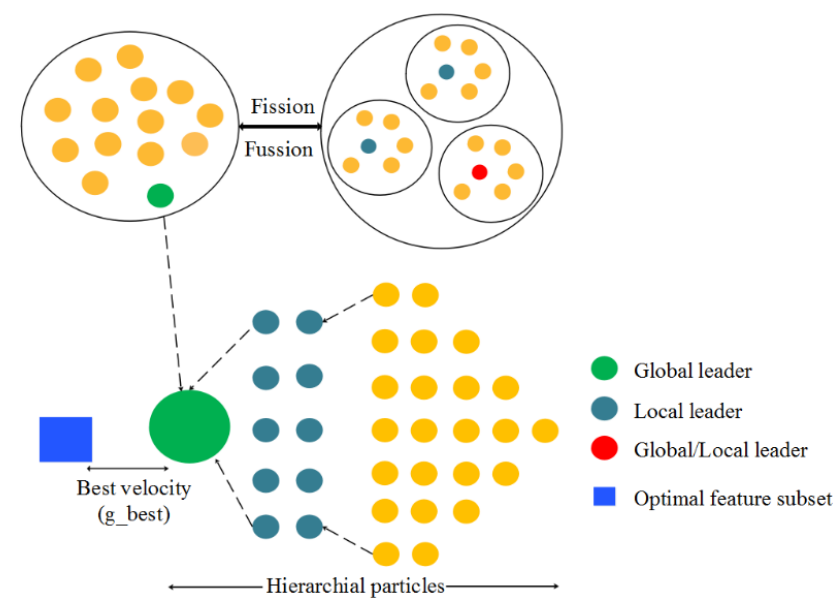
Figure 4. Pictorial representation of the proposed hybrid SMO-HPSO for selecting g-best feature. The hybridization of SMO with the PSO algorithm generates the hybrid mixed func- tionality based on the low-level co-evolutionary features. The low-level hybrid functionality features merge and combine variants. The co-evolutionary is used because the variants are used one after the other, running in parallel. The two distinct variants are mixed and are involved in the generation of solutions to overcome the problems. Based on this modifica- tion, the hierarchical PSO has the ability to explore SMO to produce the variants with its strength. The PSO and SMO variants are combined, updating the velocity as proposed in Equations (10) and